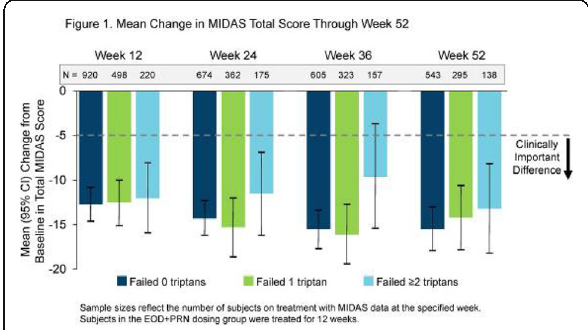
Fig. 1 (abstract P0269). See text for